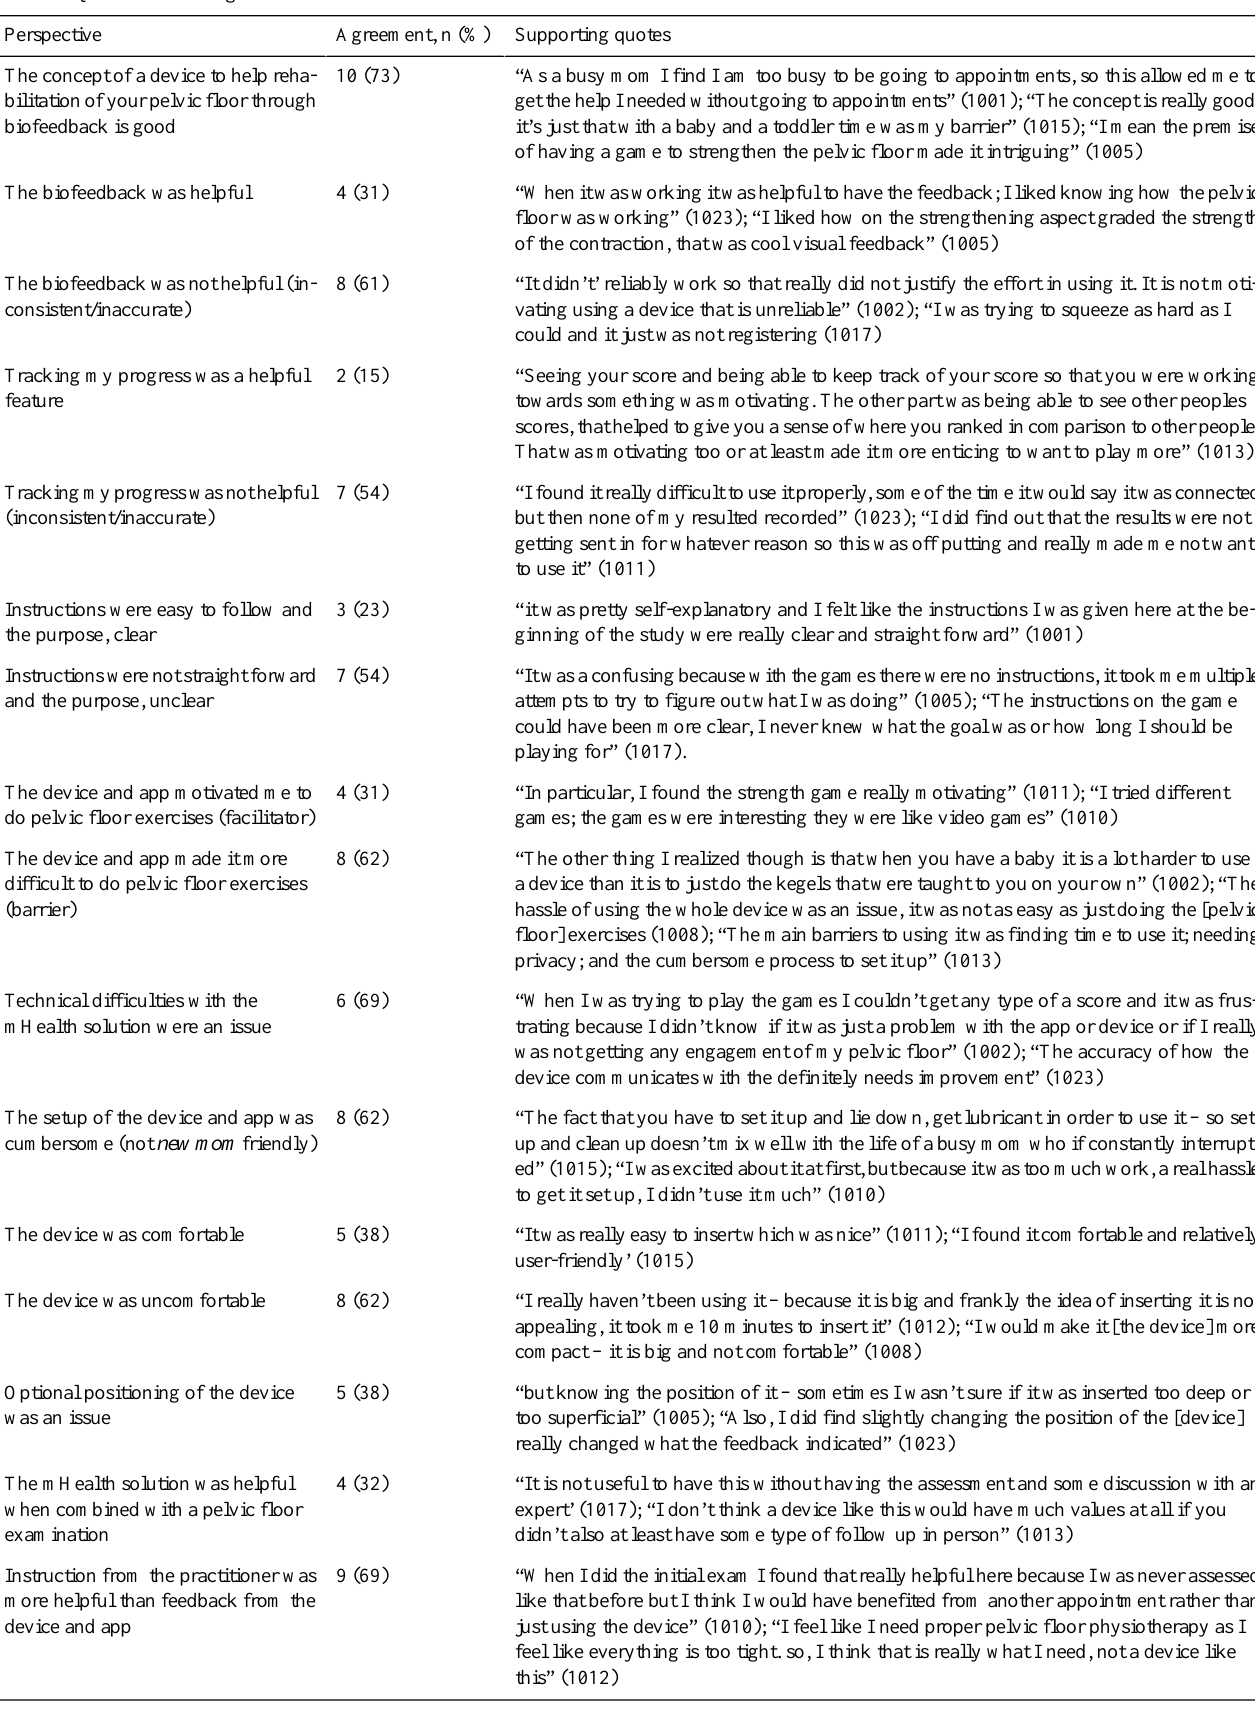
Table 7. Qualitative findings.